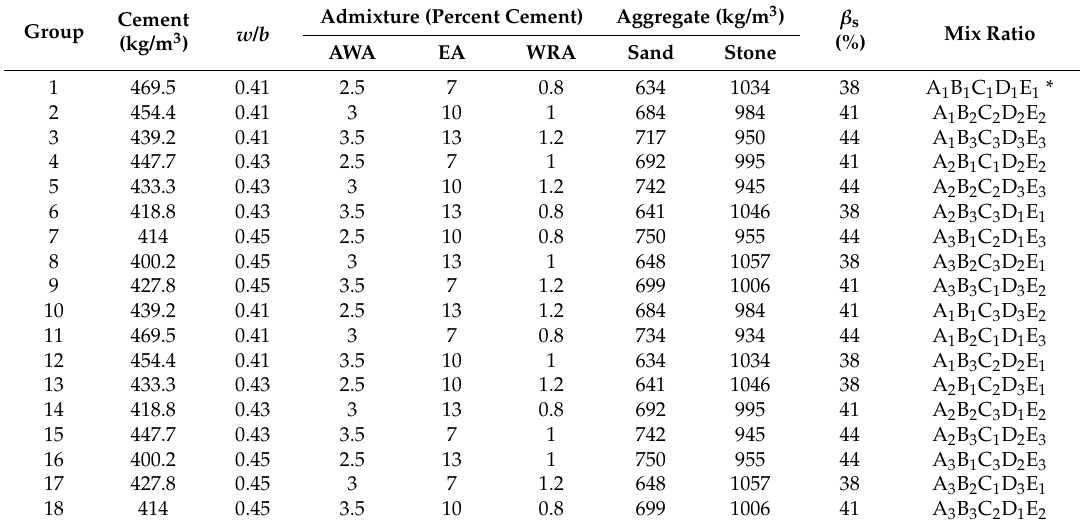
Table 13. The mix ratio of orthogonal tests.